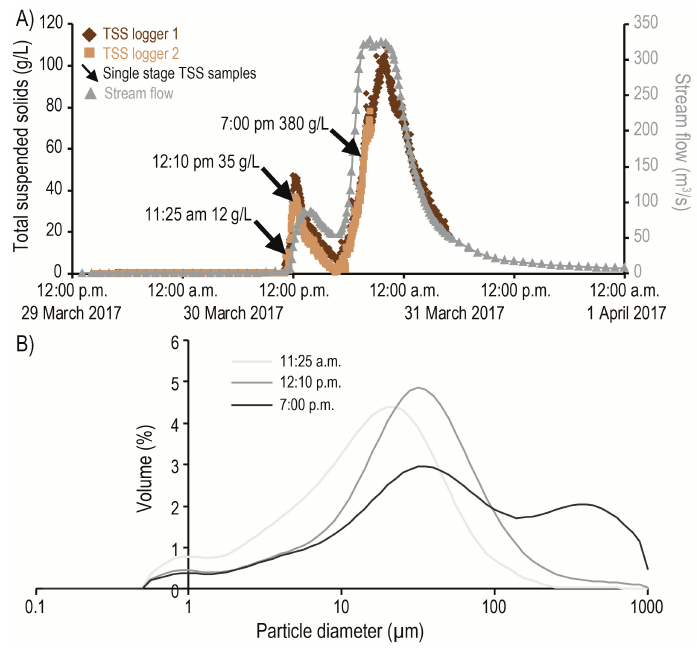
Figure 6. ( A ) TSS measurements recorded from two low-cost sensors and stream flow during the high flow event proceeding the passage of Ex-Tropical Cyclone Debbie. Discrete single stage sample timing and concentrations are indicated with arrows. ( B ) Particle size distribution for samples collected by single stage samplers on 30 March 2017 during the initial phases of the flood